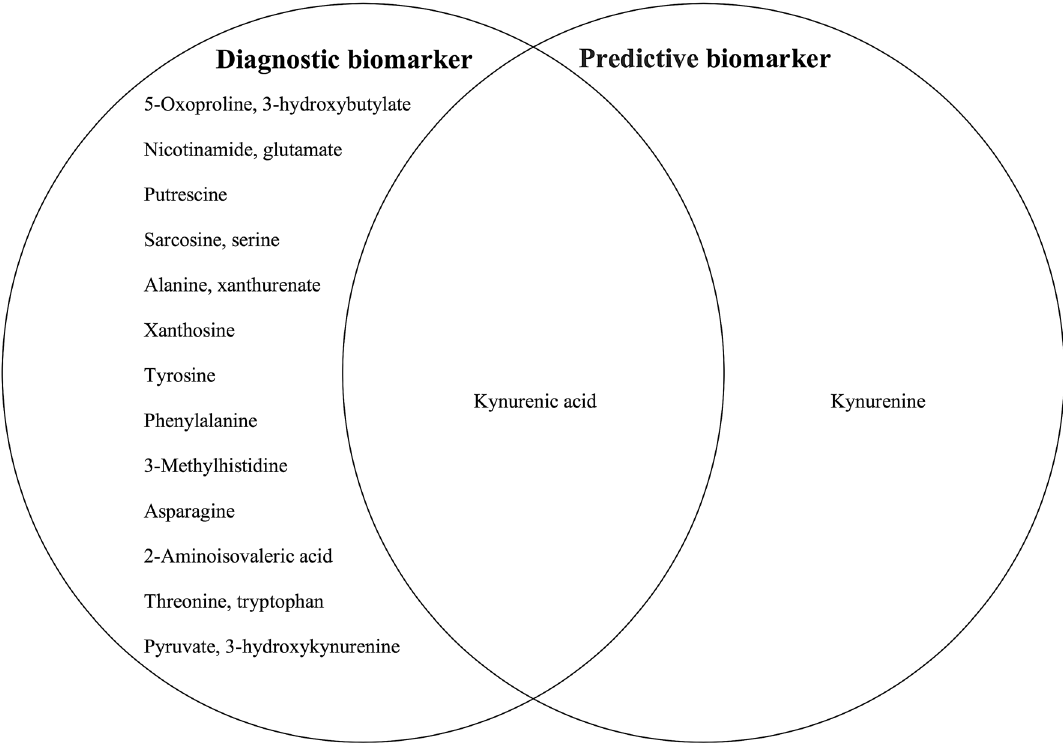
Figure 1. Venn diagram of diagnostic and predictive biomarkers. Twenty metabolites were identified as the diagnostic biomarker. Two metabolites were identified as predictive biomarker. Only kynurenic acid was identified as both diagnostic and predictive